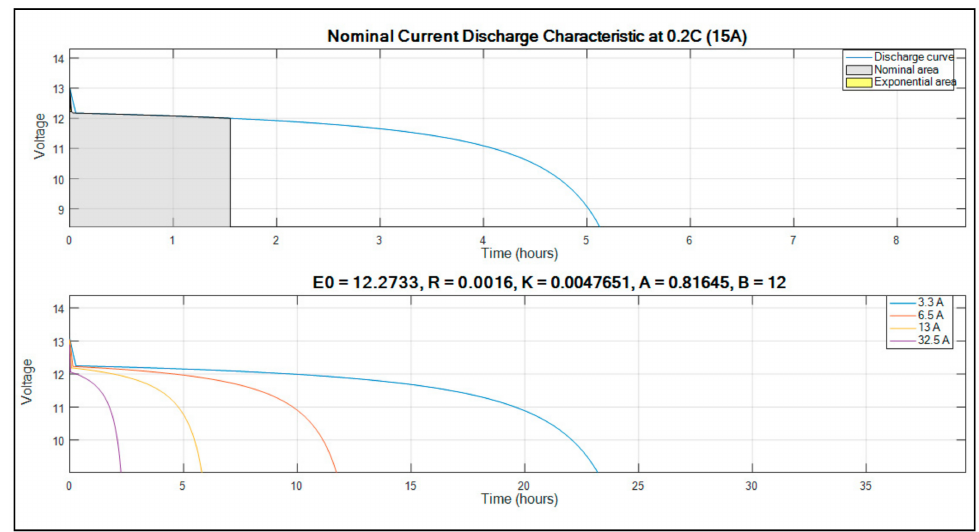
Figure 3. Modelled LAB